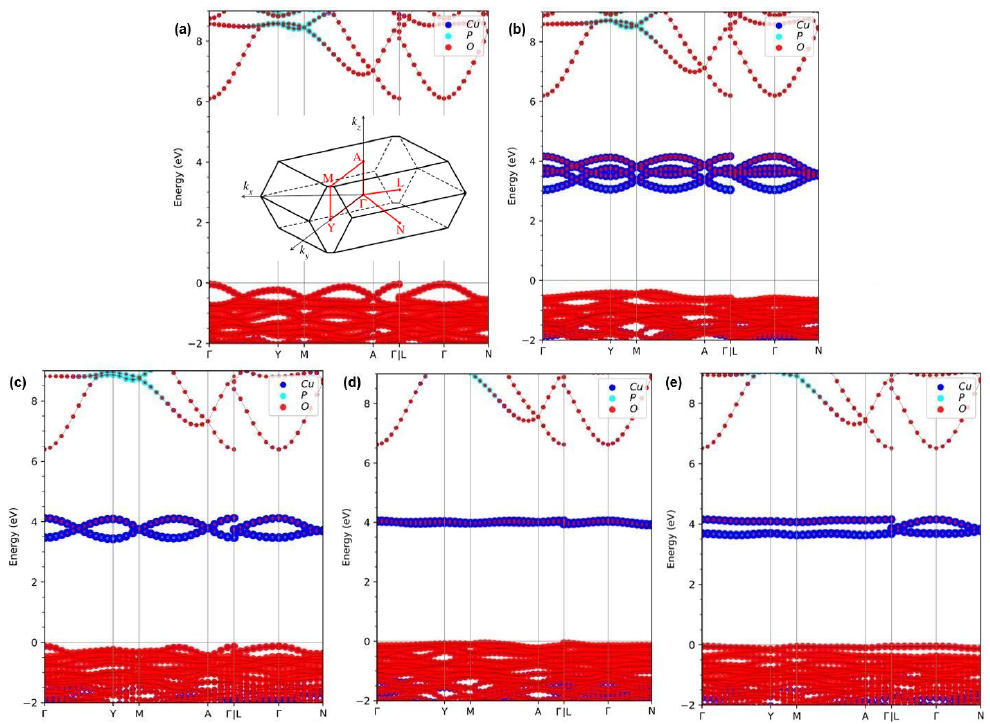
Figure 2. Fat band structures for α -Cu 2 P 2 O 7 in ( a ) FM spin-up channel, ( b ) FM spin-down channel, ( c ) AFM-1, ( d ) AFM-2, and ( e ) AFM-3 magnetic states calculated within HSE density functional. The zero energy is chosen at the highest occupied level at 0 K. The inset in panel ( a ) shows the BZ shape and paths used in the electronic and phonon spectrum